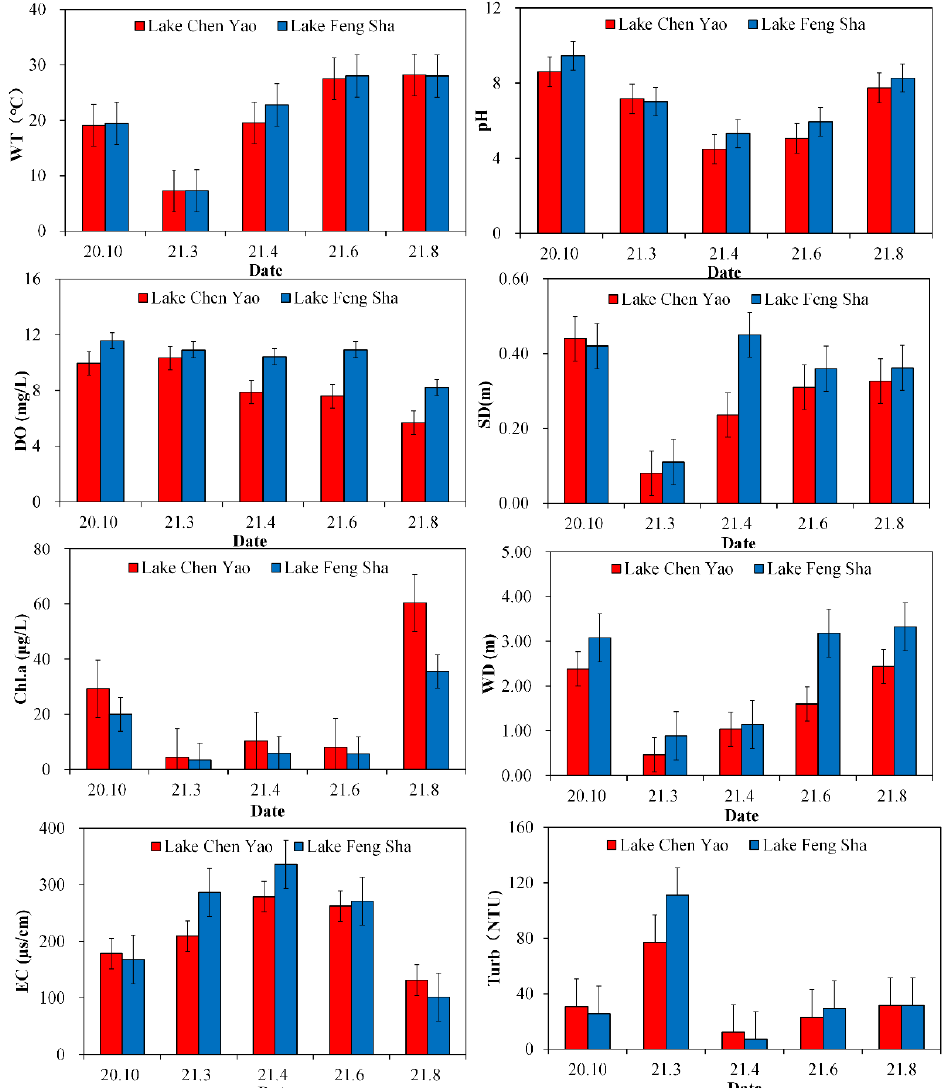
Figure 3. Seasonal changes of physical and chemical factors in Lake Chen Yao and Lake Feng Sha.